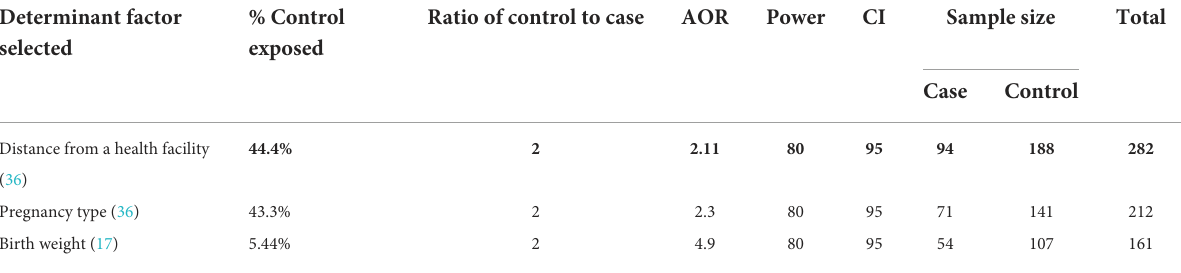
TABLE 1 Sample size calculation to identify determinants of NNM among neonates in public hospitals of Ilu Abba Bor Zone, 2020. Determinant